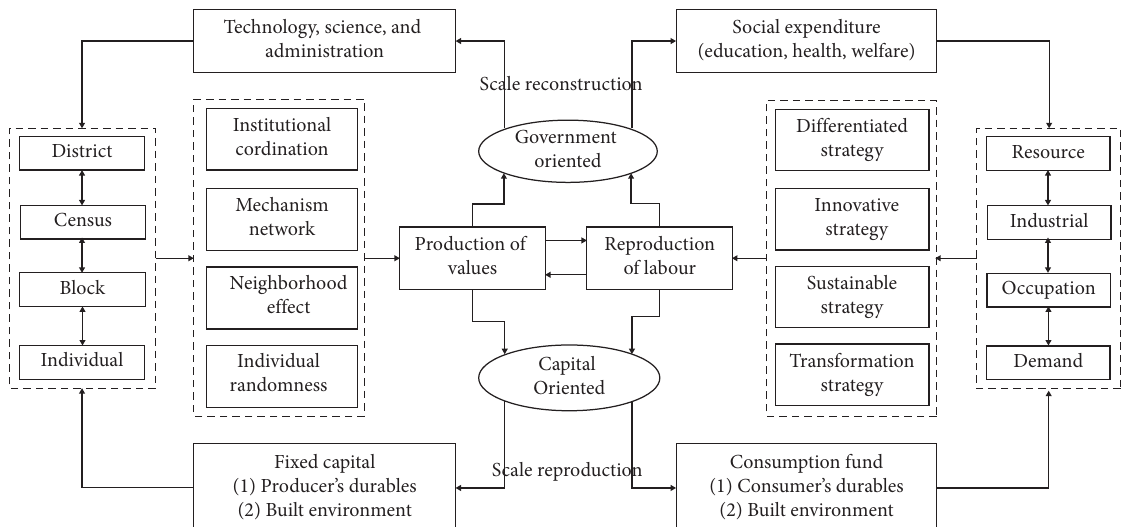
Figure 1: The capital circulation of the geographic scales’ reconstruction and